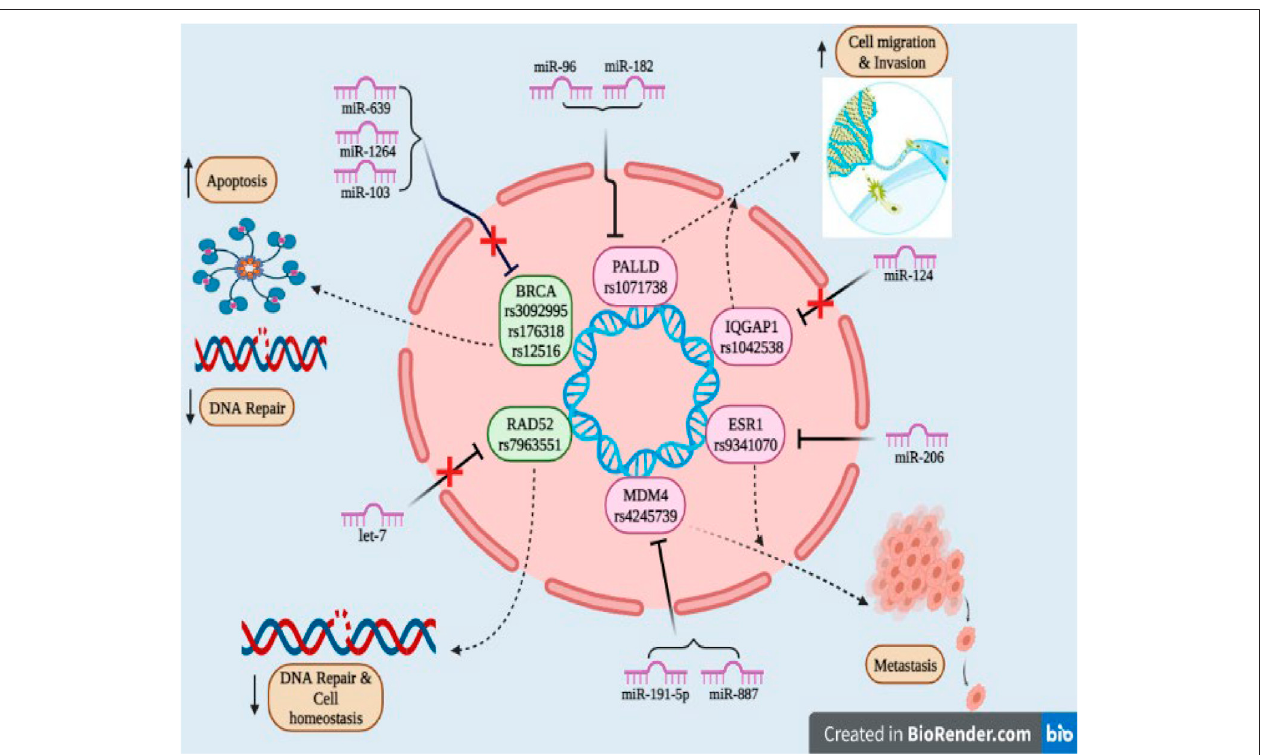
FIGURE 2 | SNPs reported in 3 ′ UTR region of the target gene involved in cancer: Due to SNPs in the BRCA gene (rs3092995, rs176318, rs12516) and RAD52 gene (rs7963551) binding site for miR-639, miR-1264, and miR-103 within BRCA and for let-7 within the RAD52 gene found to be disrupted and as tumor suppressor genesthey promote cellapoptosis, decrease theDNArepair mechanism andmaintaincellhomeostasis;PALLD(rs1071738), IQGAP1 (rs1042538),ESR1 (rs9341070), and MDM4 (rs4245739) genes act as oncogenes and they are responsible for metastasis, cell migration, and